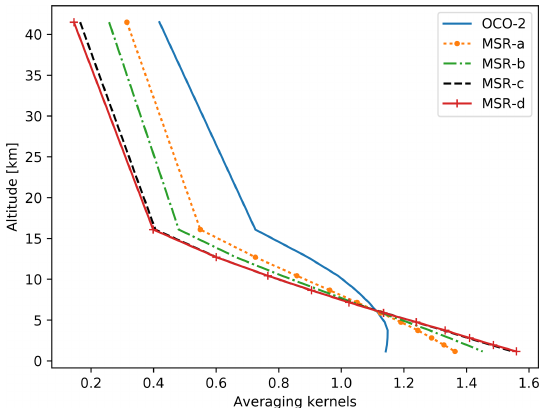
Figure 8. Example of an averaging kernel of OCO-2 and MSR re- trievals in RemoTeC. The observation is obtained close to the TC- CON site Lamont under nadir mode with a solar zenith angle of 20 . 5 ◦ . Averaging kernels are plotted as a function of central height of the CO 2 atmosphere